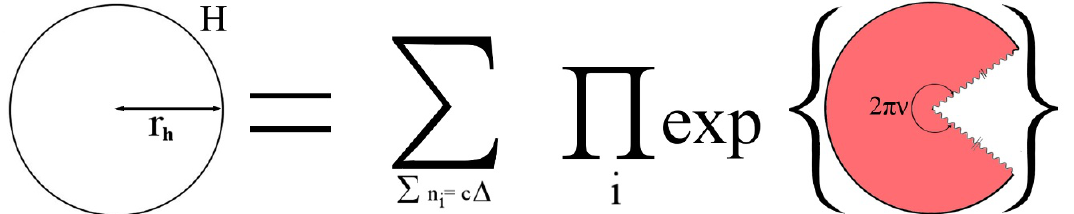
Figure 4 : Schematic depiction of horizon (cid:13)u(cid:11)